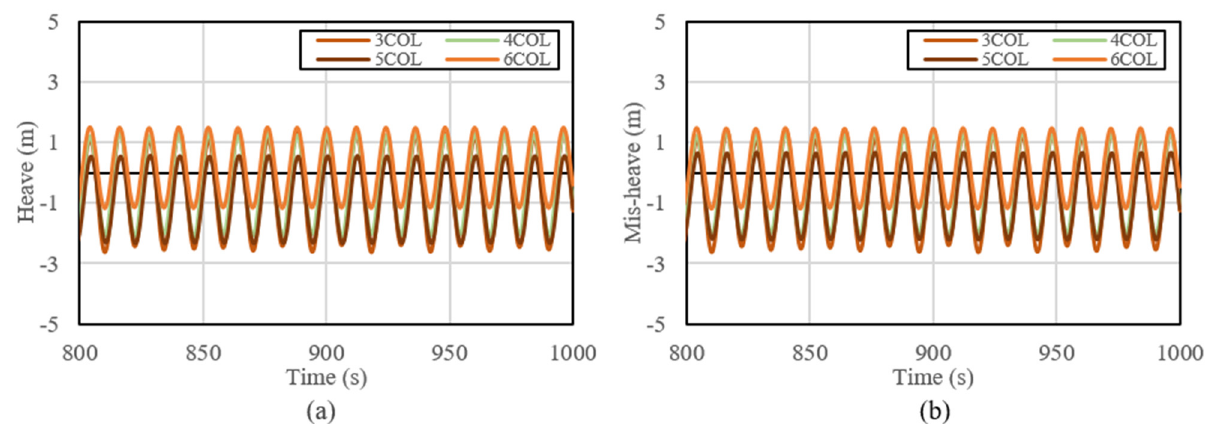
Figure 19. Heave results for different types of platforms (( a ): direction of waves and wind aligned; ( b ): direction of waves and wind misaligned).